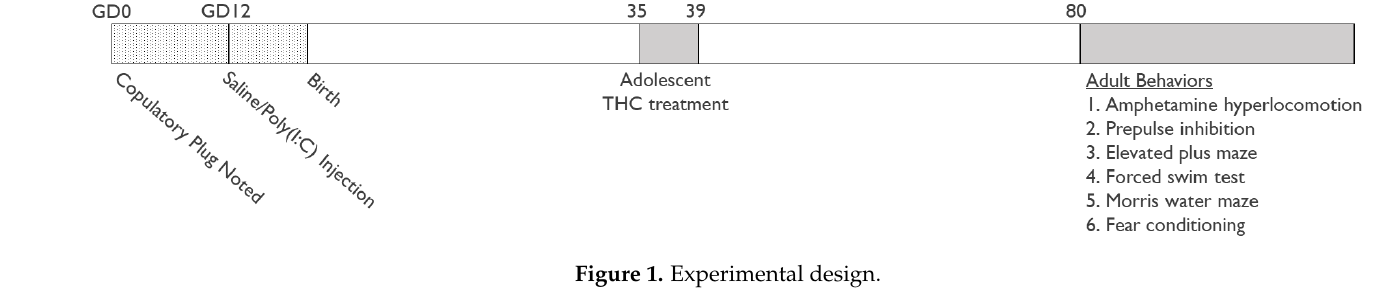
Figure 1. Experimental design.